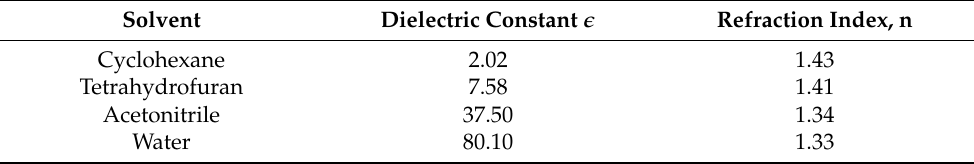
Table 1. Dielectric constants and refraction indices of the solvents used in this work. Solvent Dielectric Constant (cid:101) Refraction Index, n Cyclohexane Tetrahydrofuran